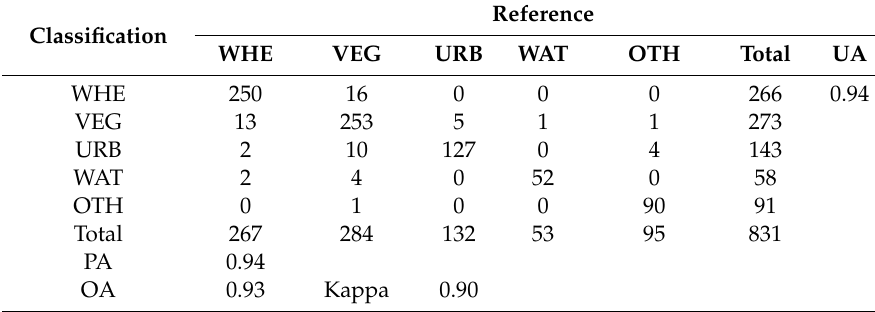
Table 4. The error matrix of RF.